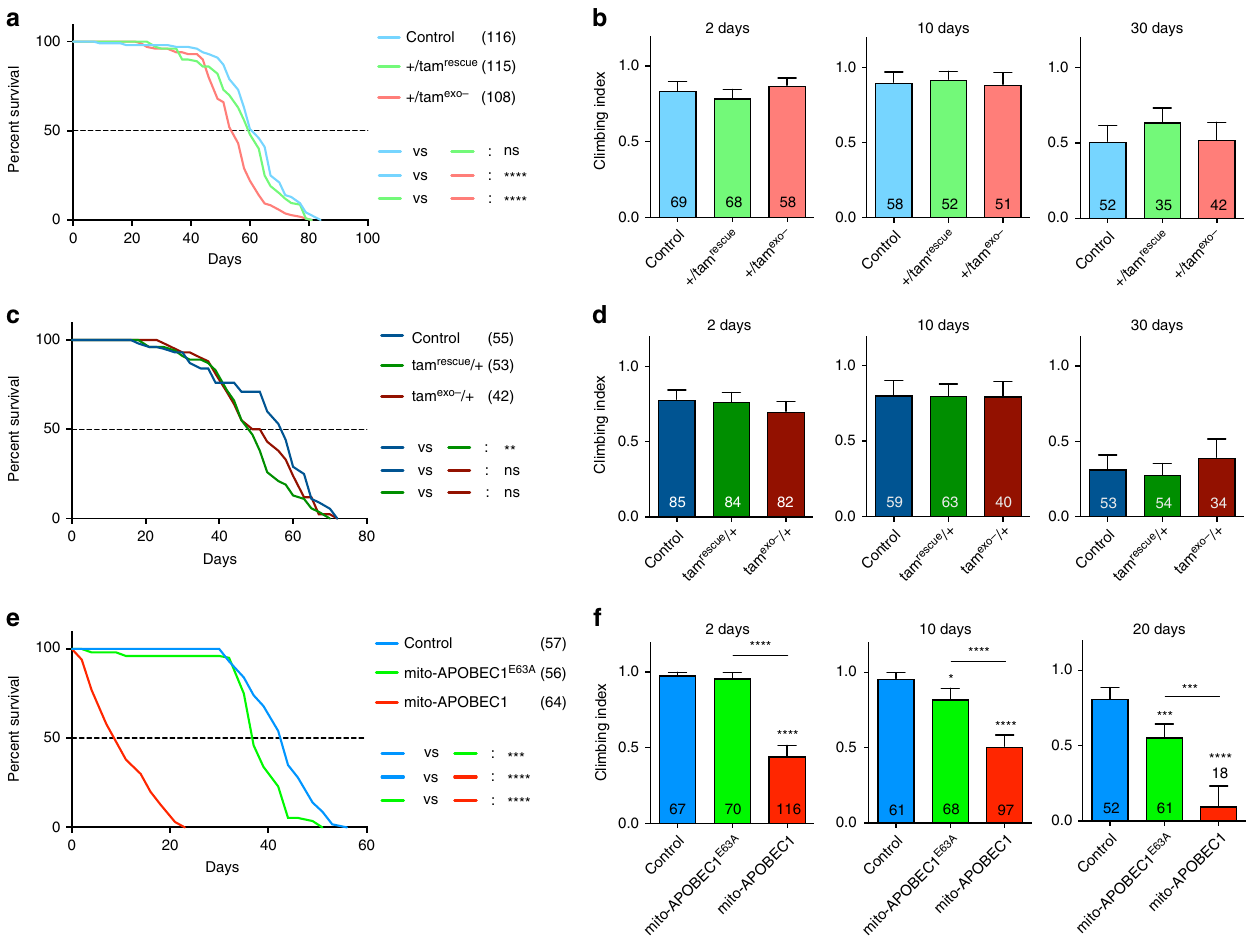
Fig. 4 mito-APOBEC1 but not tam exo − impacts fl y lifespan and locomotor ability. a , c , e Lifespan and b , d , f locomotor (climbing) ability were assessed for a , b paternally inherited tam exo- , c , d maternally inherited tam exo − and e , f mito-APOBEC1 fl ies and respective controls. Only male fl ies were tested. For lifespan, statistical signi fi cance was determined by Log-rank (Mantel – Cox) test; the number of animals tested are indicated in the legend. For locomotor assays, charts show mean ± 95% con fi dence interval. The number of animals tested are shown per column. Statistical signi fi cance was determined by Kruskal – Wallis nonparametric test with Dunn ’ s multiple comparisons correction. * P < 0.05, ** P < 0.01, *** P < 0.001, **** P < 0.0001. All other comparisons are non-signi fi cant but are not indicated to aid clarity. Source data are provided as a Source Data fi (Fig. 5c). Assessing the steady-state levels of the assembled com- plexes by native-PAGE immunoblotting we found that mito- APOBEC1 fl ies consistently displayed decreased amounts of higher-order assemblies of Complexes I, III, IV and V (Fig. 5d), with partial accumulation of non-functional intermediates. MtDNA mutations could potentially also impact transcription, causing a decline in transcript levels. To assess this, we analysed several transcripts from the mitochondrial genome by quantita- tive RT-PCR. Expression of the catalytically dead mito- APOBEC1 E63A resulted in a moderate but signi fi cant reduction of all mitochondrial transcripts analysed (Fig. 3f), which mirrored the lowered amounts of mtDNA copies in these fl ies (Fig. 3b, d). In contrast, transcript levels in mito-APOBEC1 fl ies were comparable or slightly higher than controls (Fig. 3f). Taken together, these data indicate that mito-APOBEC1 -induced muta- tions compromise OXPHOS assembly and respiration likely by components.